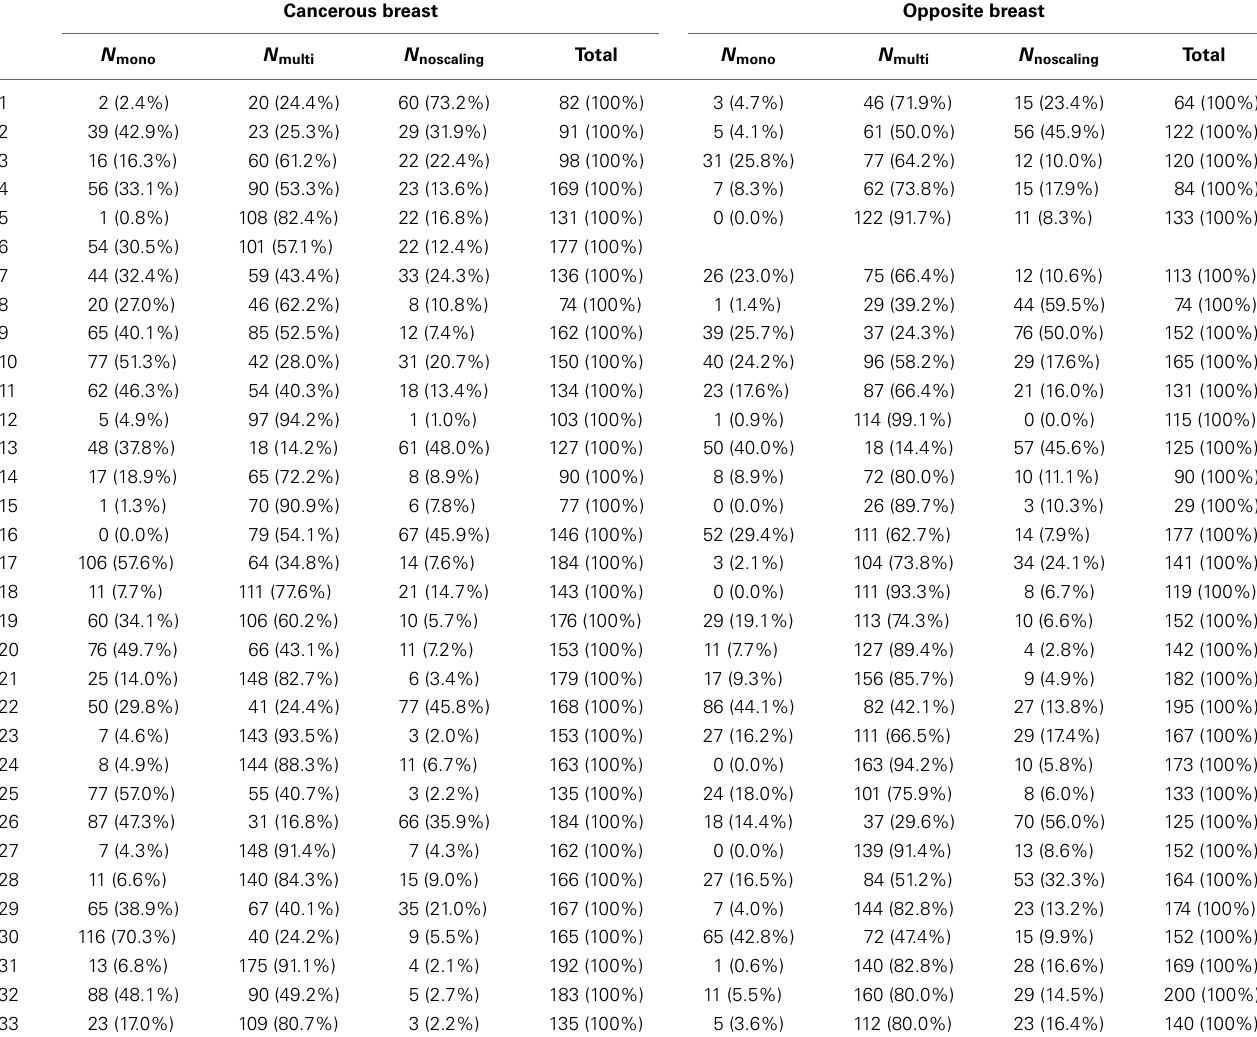
Table 2 | Results of our WTMM multifractal analysis of the skin (cumulative) temperature temporal fluctuations of the two breasts of our 33 patients with breast